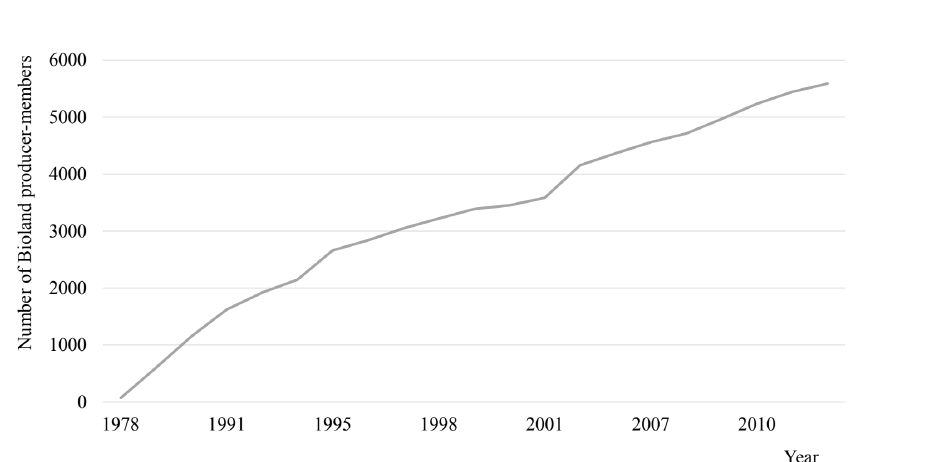
Figure 1. Bioland’s membership development fi gures 1978-2012. Source: Authors’ own data collected from membership fi gures in various issues of the journals listed in Table 1 and the annual statistics of the Bundesverband Oekologische